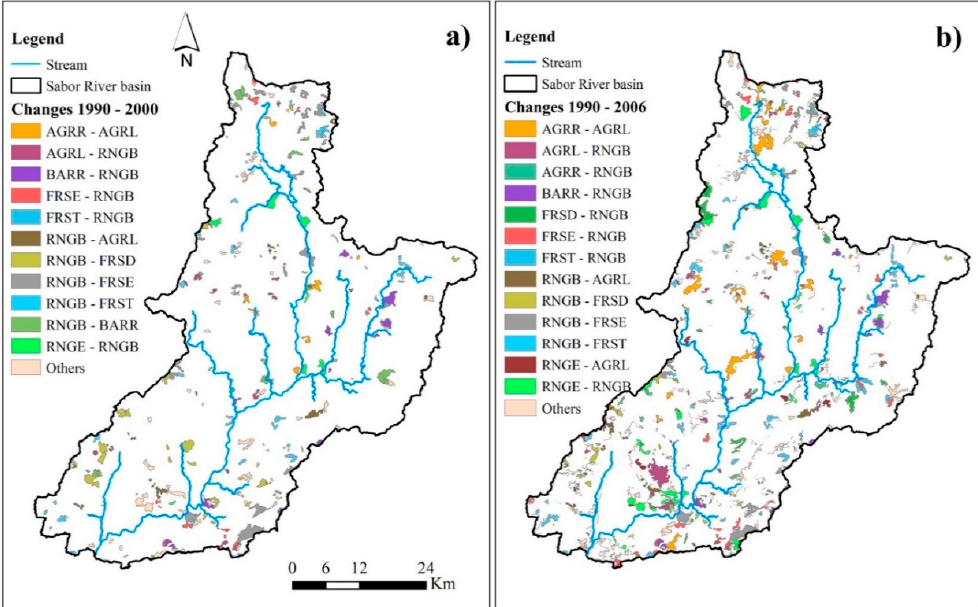
Figure 2. The spatial distribution of changes ( a ) between the CORINE Land Cover 1990 and 2000; and ( b ) between the CORINE Land Cover 1990 and 2006, in the Sabor river basin. Only the areas with changes greater than 500 hectares are presented. The SWAT codes are agricultural land—row crops (AGRR), agricultural land—generic (AGRL), range—brush (RNGB), range—grasses (RNGE), barren (BARR), forest—deciduous (FRSD), forest—evergreen (FRSE), and forest—mixed (FRST).